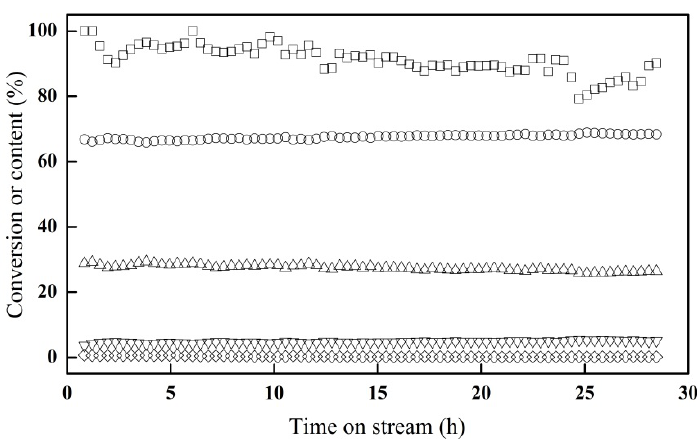
Figure 7. Catalytic stability test for steam reforming of toluene using (3 wt%)/SBA-15 catalyst. ( □ ) toluene conversion; ( ○ ) H Ni-CeO 2 content; and ( ◊ )CH ( ∇ ) CO 2 4